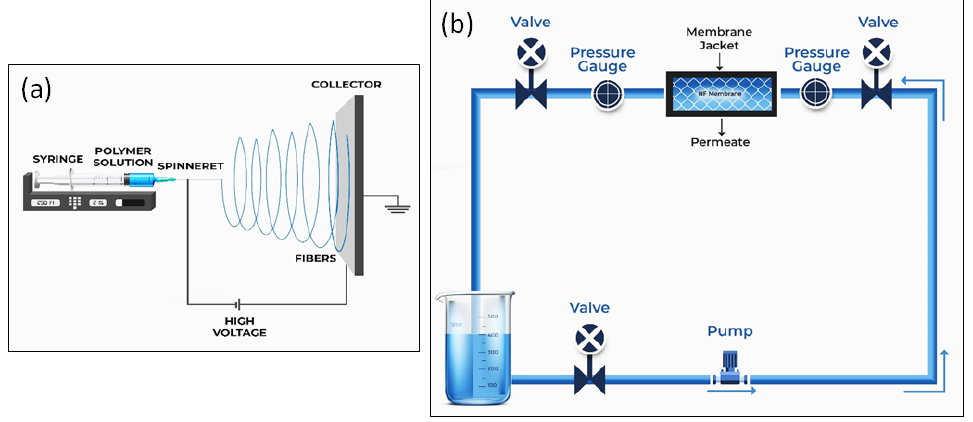
Figure 1. Schematic diagram of ( a ) electrospinning and ( b ) nanofiltration process [15] . Table 1. Electrospinning parameter and solution properties used for membrane